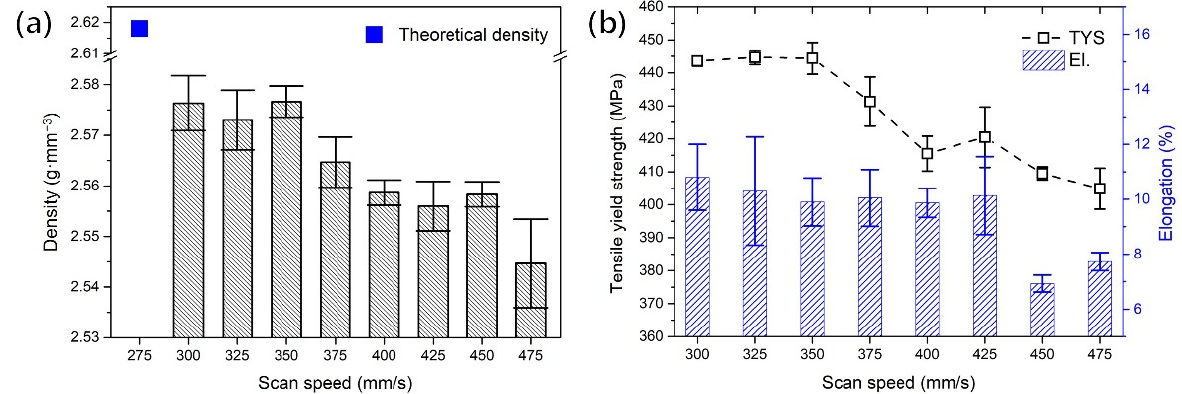
Figure 3. Comparison of various scan speeds: ( a ) relative densities, ( b ) TYS and elongation.